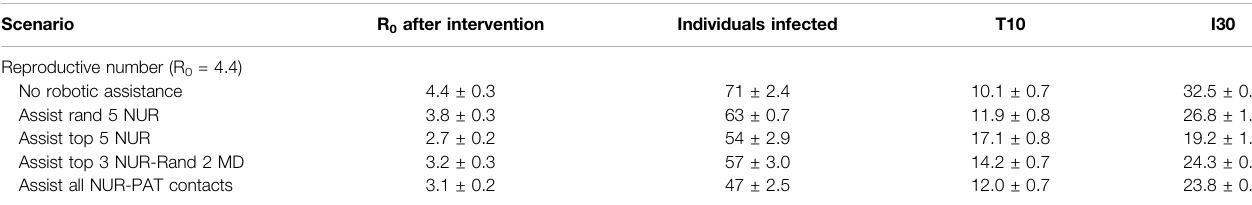
TABLE 1 | Measures of the temporal evolution of infection spreading for a baseline case of R 0 (cid:1) 4.4. Scenario R 0 after intervention Individuals infected T10 I30 Reproductive number (R 0 (cid:1) 4.4) No robotic